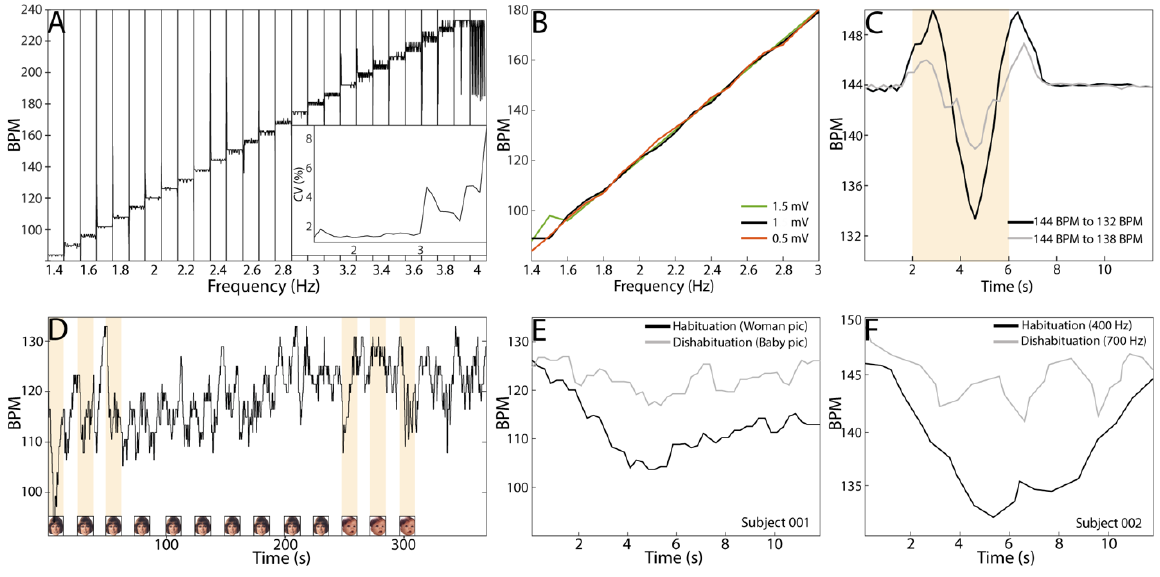
Figure 5. Response of COR sensor to synthetic and heart biopotentials. ( A ): The average curve of two ramps of artificial ECG signals on steps of 0.1 Hz is equivalent to 6 BPM every 12 s. It is possible to see the response of the COR sensor is stable at different frequencies having a coefficient of variation (CV in the insert) < 1% when the input signal is < 3 Hz. ( B ): The COR sensor mostly responds linearly to synthetic ECG signals at different frequencies (Hz) and amplitudes (mV) that match the parameters of biological ECG signals. ( C ): The COR sensor can capture variations of 4 s (yellow column) or longer on the synthetic input signal of 0.1 Hz (grey curve) through time, making this sensor suitable to detect differences in the heartbeat rhythm between populations (i.e., healthy vs. neurodevelopment delayed subjects). ( D ): Raw R-to-R time expressed as BPM during a whole session of visual stimulation. ( E ): COR triggered by the visual stimulation depicted in D where the woman pictures were used as the habituation stimulus, while the baby pictures were used as the dishabituation stimulus. The black curve represents the averaged cardiac deceleration in response to the first three visual habituation images (yellow columns) of an infant with no prenatal alcohol exposure from an Atlanta cohort. ( F ): The black trace represents the averaged cardiac deceleration in response to the first three 400 Hz habituation tones of a subject with no prenatal alcohol exposure during gestation from the Ukraine cohort. The gray curves are the averaged COR to the first three dishabituation pictures (baby face) and tones (700 Hz) for each subject and stimulus modality,